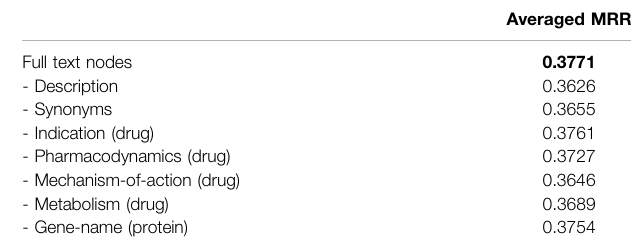
TABLE 6 | Ablation study of text information on Augmentation method (ComplEx score